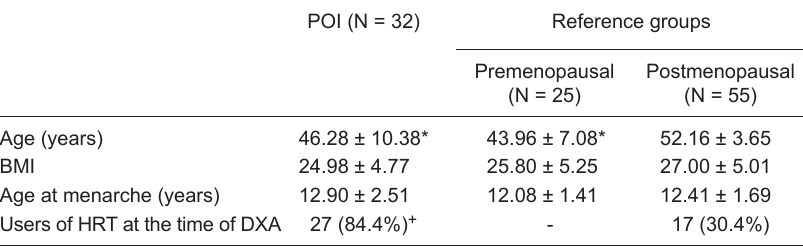
Table 1. Characteristics of women with primary ovarian insufficiency and reference groups at the time of dual-energy X-ray